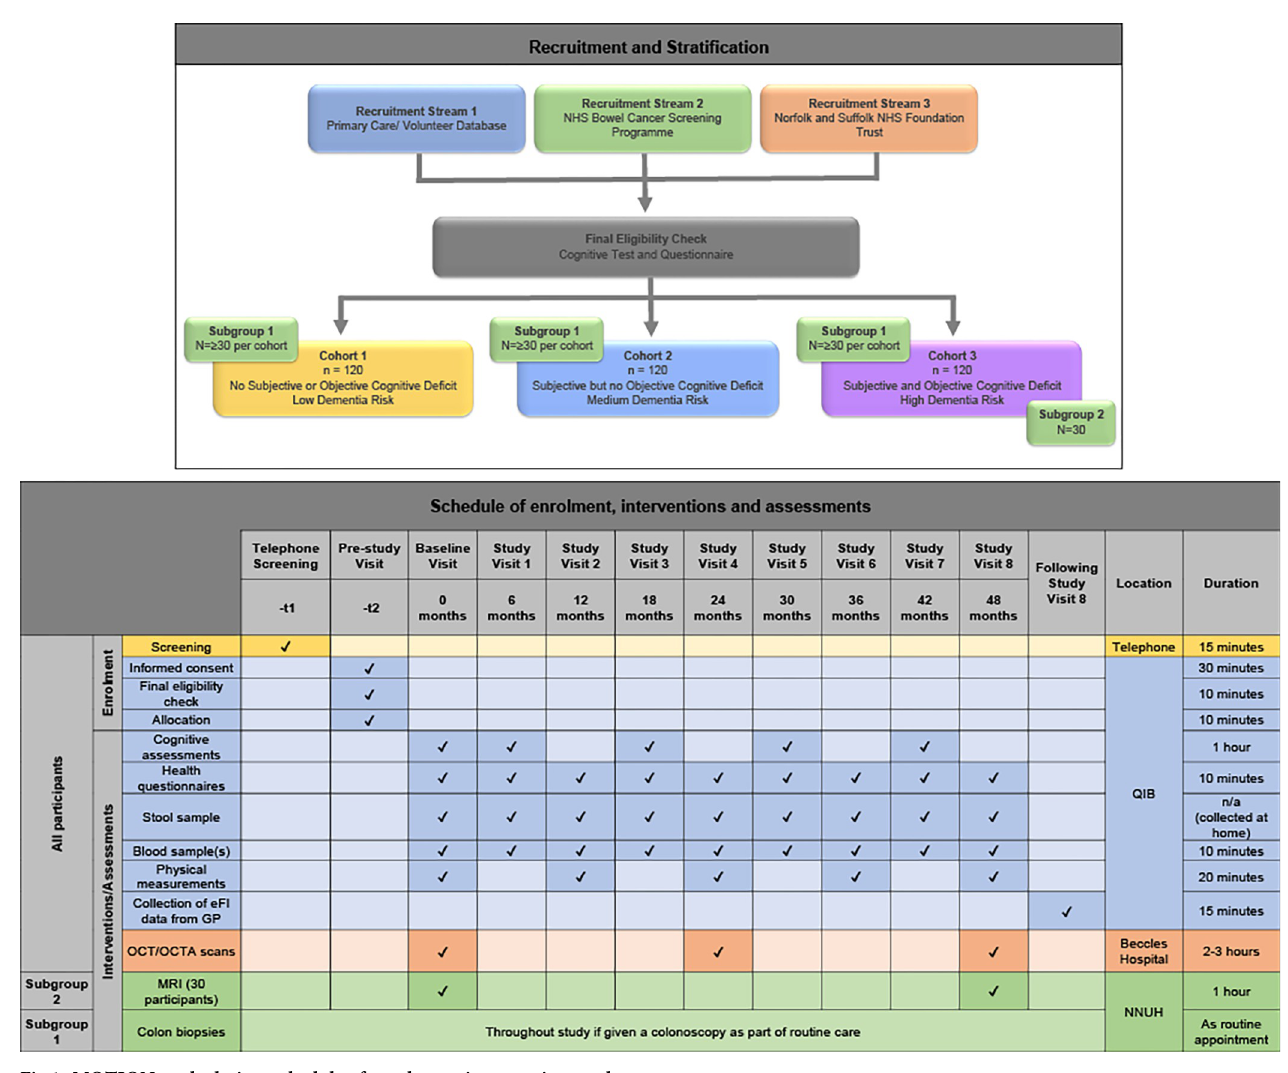
Fig 1. MOTION study design, schedule of enrolment, interventions and